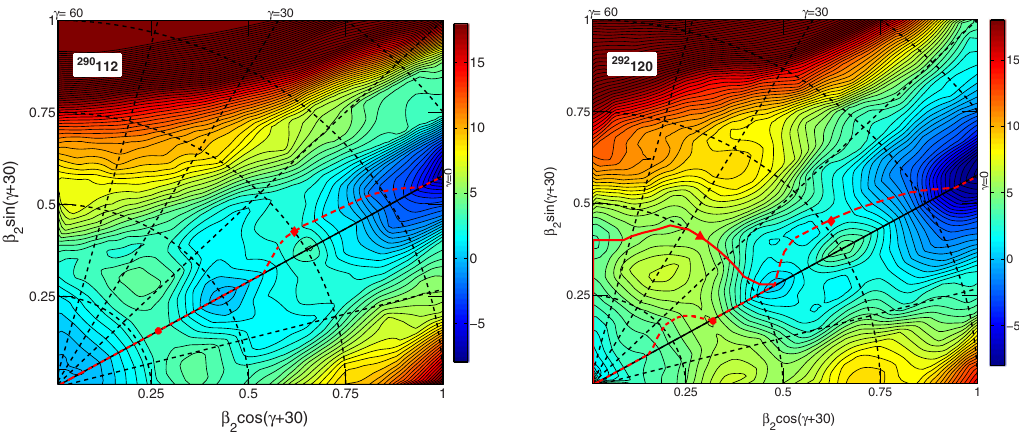
Figure 2. Potential energy surfaces of selected nuclei. The energy difference between two neighboring equipotential lines is equal to 0.5MeV. The saddles along the “Ax” and “Tr-A” fission pathes are shown by solid circles and triangles, respectively. The solid diamonds show the outer fission barrier saddles. From Ref.